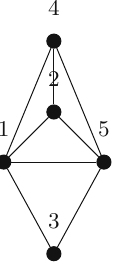
Figure 1: Subgroup intersection graph of cyclic group of order 6